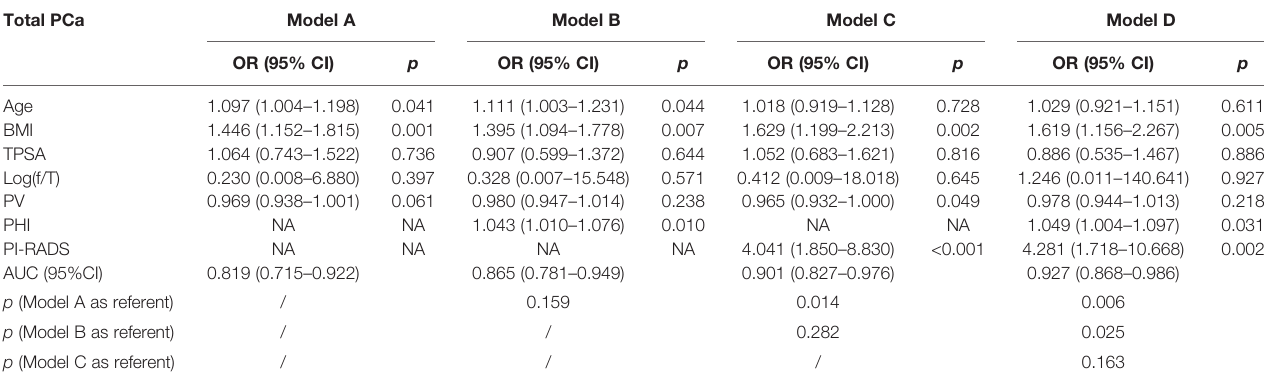
TABLE 3A | Multivariable analysis of the predictive value of the different models in the diagnosis of PCa in the PSA 4 – 10 ng/ml.